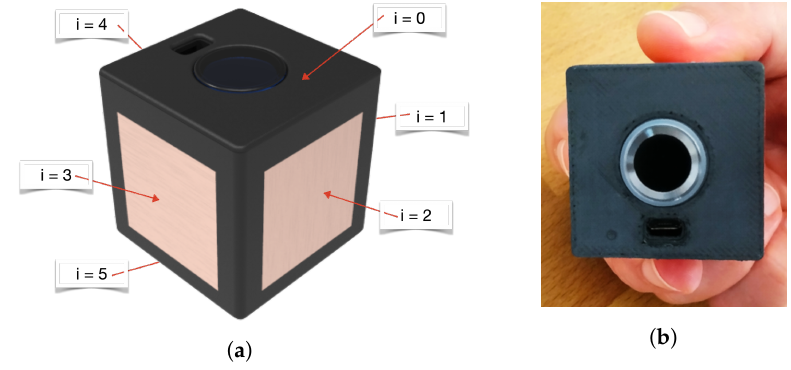
Figure 7. TactCube faces: ( a ) Numbered faces; ( b ) touched